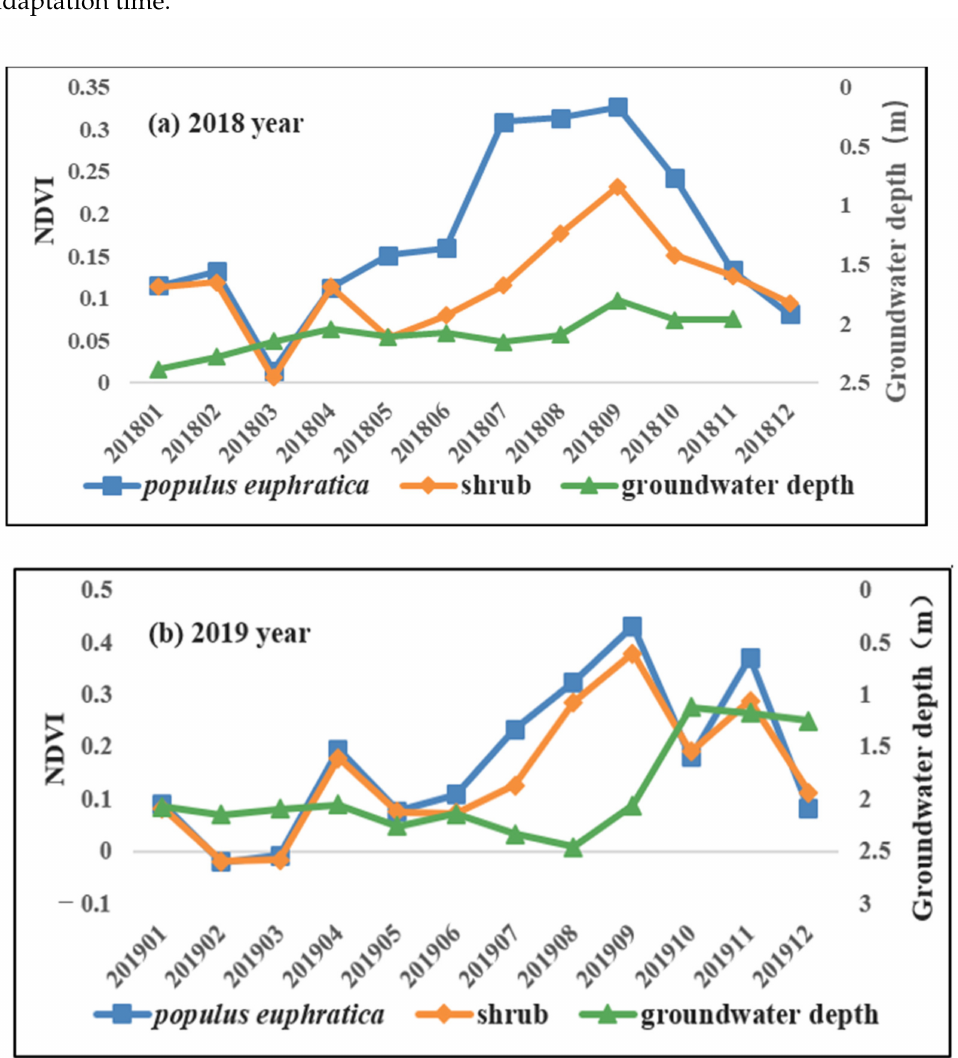
Figure 6. Comparison of groundwater level and natural vegetation NDVI in Eichmann Lake in 2018 ( a ) and 2019 ( b